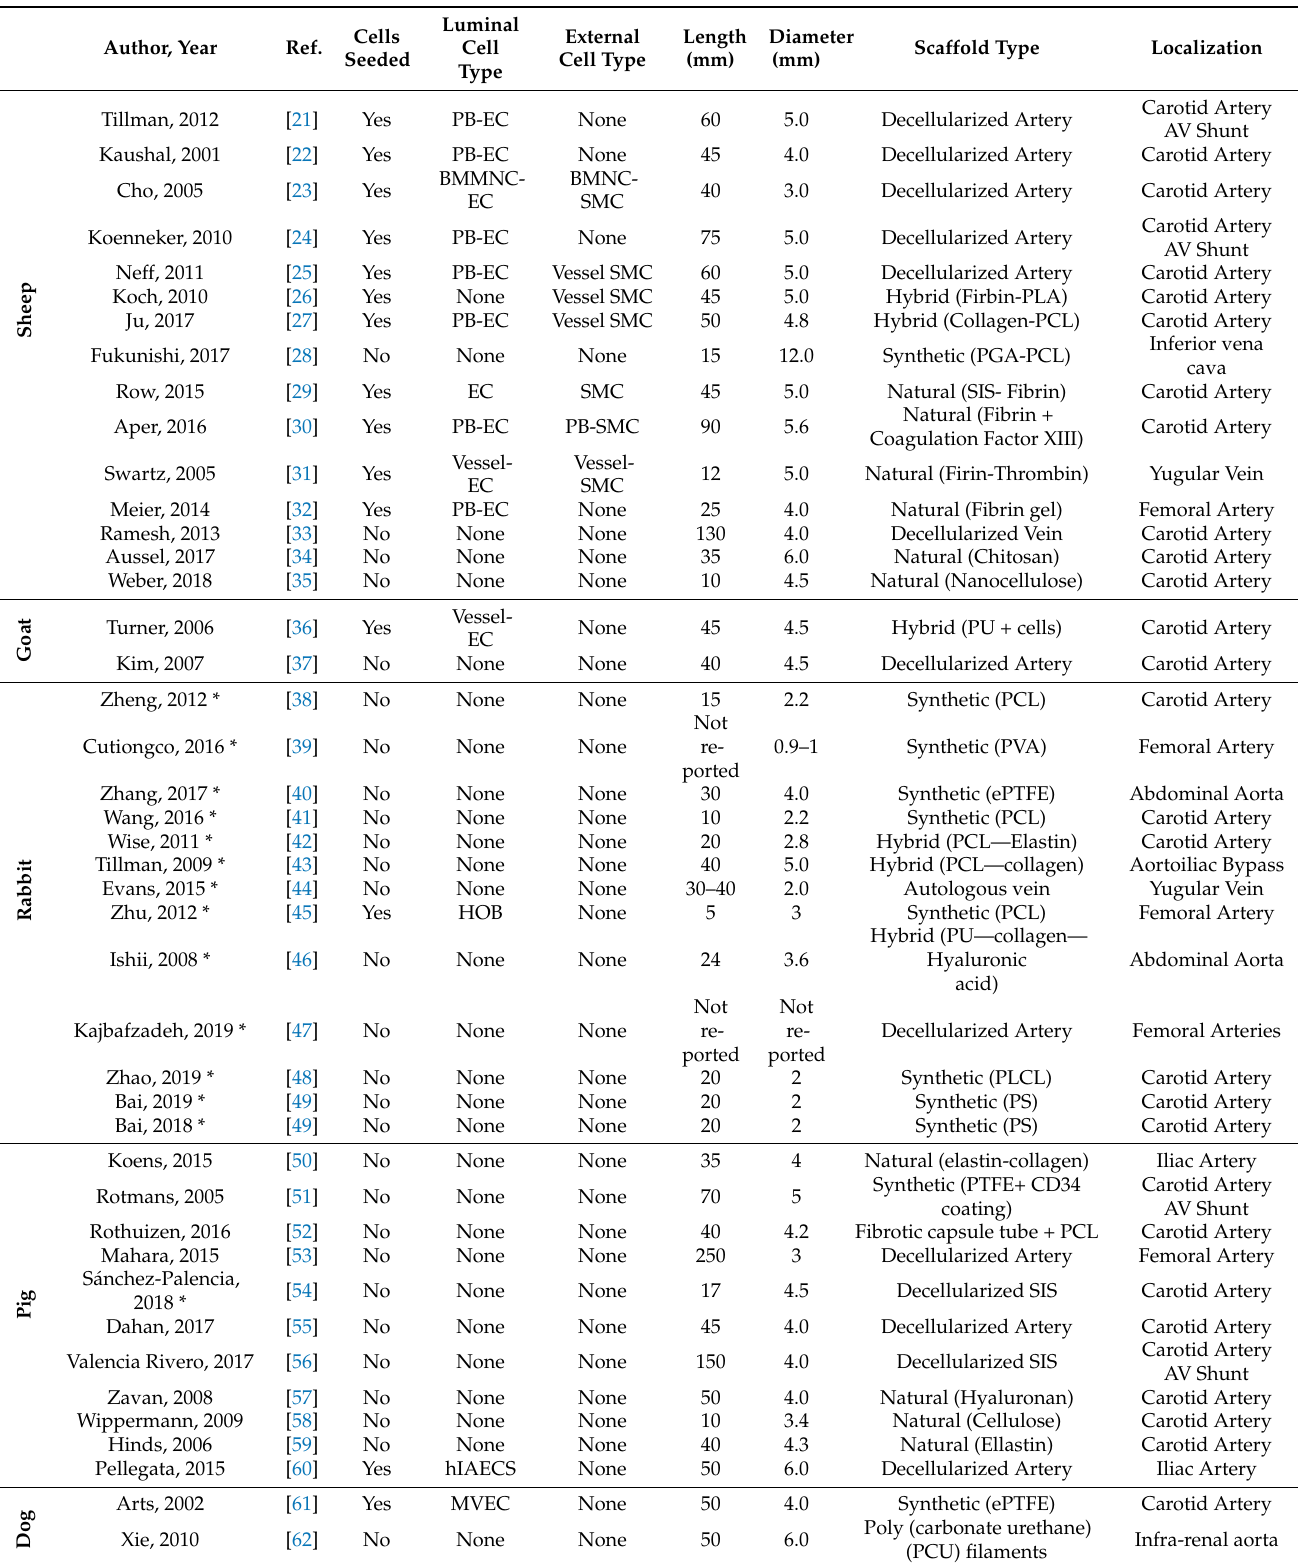
Table 2. Summary of pre-clinical animal models analyzed for this